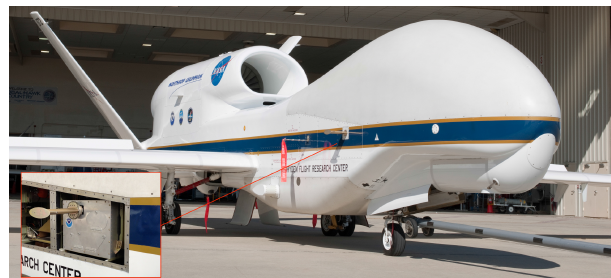
Figure 6. Photo of the NASA Global Hawk showing the location of the NOAA Water instrument inlet during the ATTREX mission (photo: T. Tschida, NASA; inset photo: T. Thornberry).